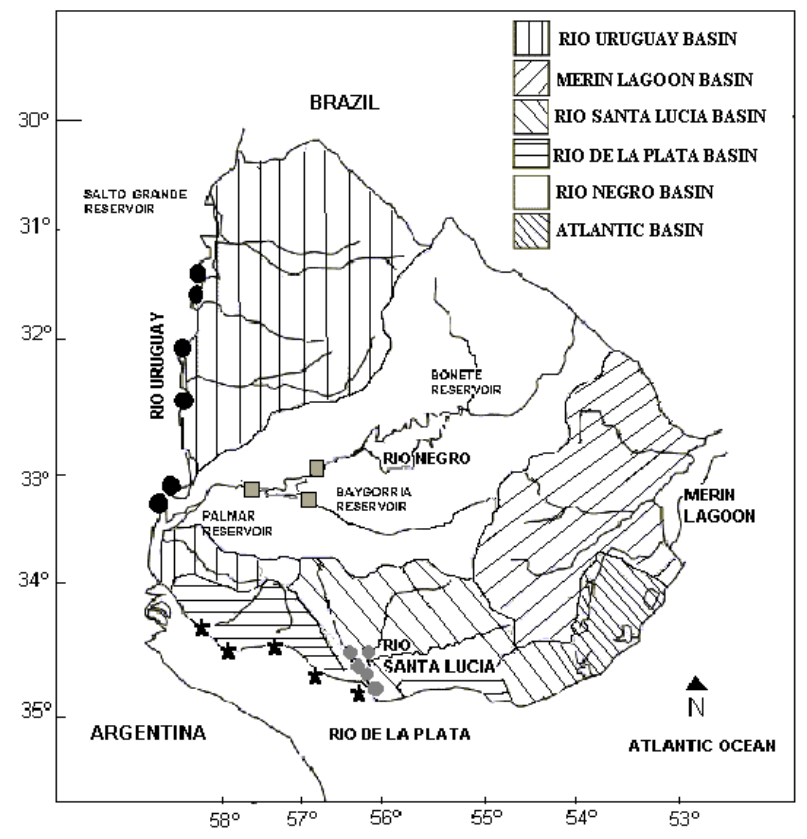
Fig. 1 – Distribution of golden mussel ( Limnoperna fortunei ) to 2003 in the main Uruguayan hydrographical basins (Map from Conde and Sommaruga 1999). Río de la Plata (*), Santa Lucía ( ◦ ), Negro ( (cid:1) ) and Uruguay Rivers ( •